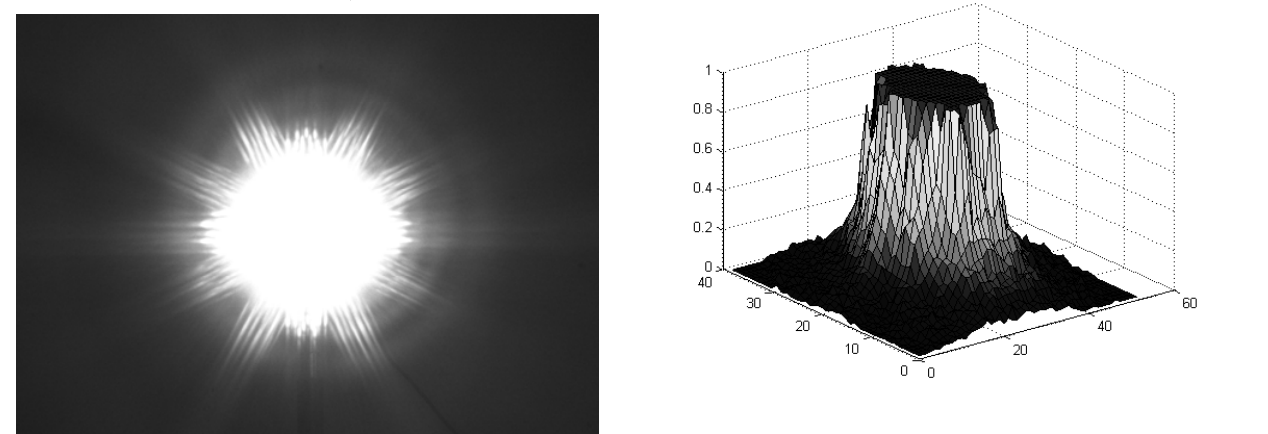
Figure 7. Characterizing function for the direction from point 2 (Heer,